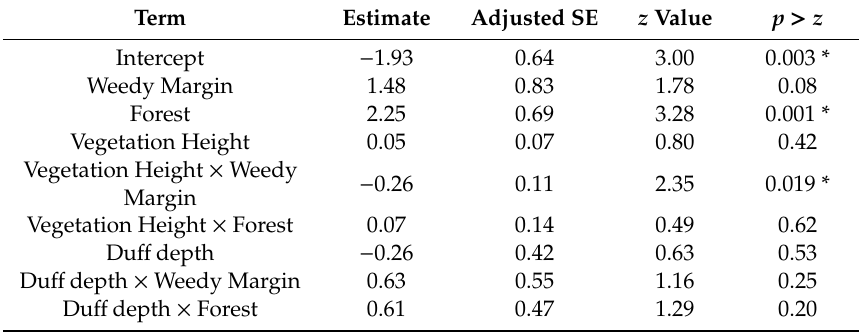
Table 4. Parameter estimates of model averaging using selected models (habitat, habitat × vegetation height, and habitat × du ff depth) of environmental variables a ff ecting the abundance of A. americanum adults.